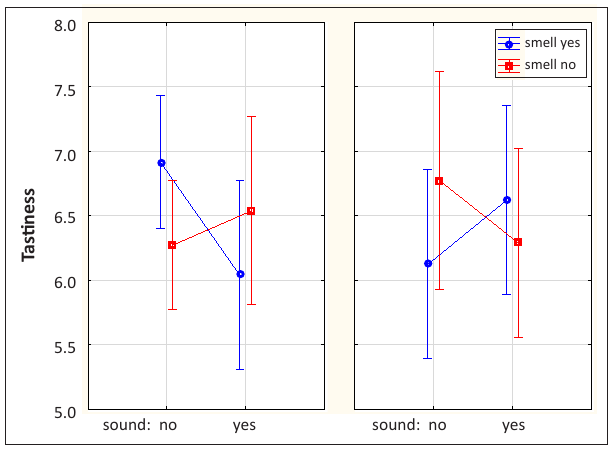
FIGURE 1 : Three-way interaction effect of sound, sight,